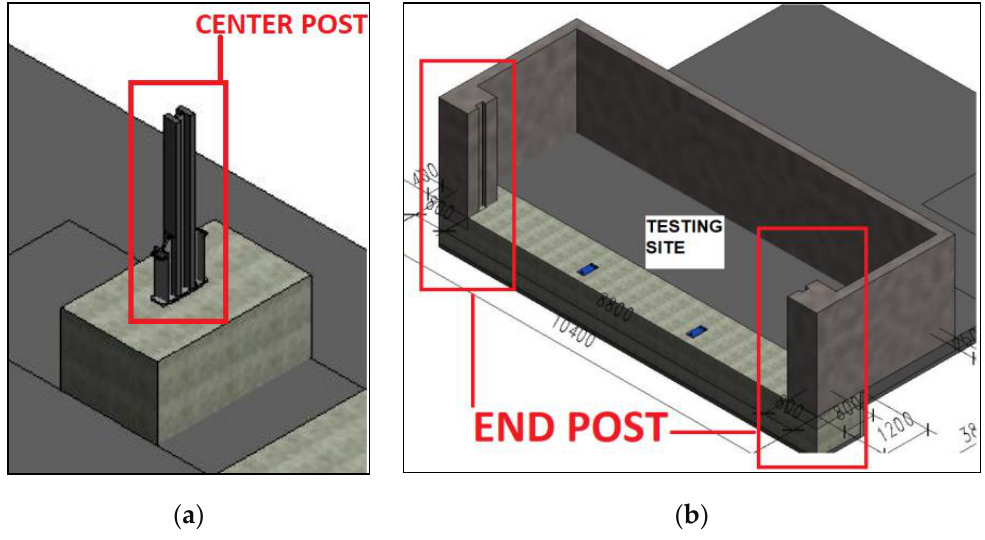
Figure 8. BIM model of center post and end post. ( a ) Center post, ( b ) end post.